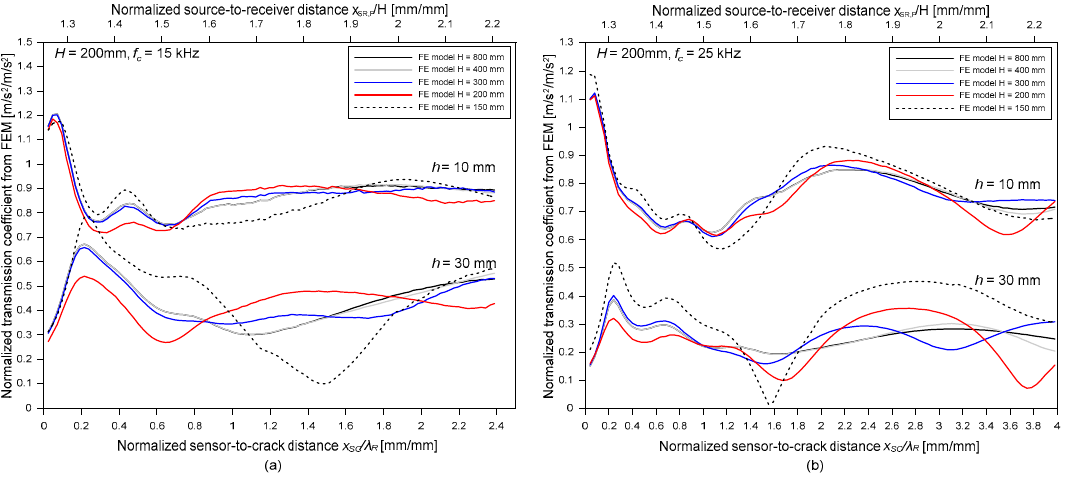
Figure 9. Variation of normalized transmission coefficient of surface waves, Tr n , in the FE models with various plate thicknesses ( H = 150, 200, 300, 400, and 800 mm), with respect to two relative sensor locations (normalized source-to-receiver distance, x SR /H and normalized receiver-to-crack distance, x RC / λ R ) at the two frequencies : ( a ) f c = 15 kHz, and ( b ) f c = 25 kHz.